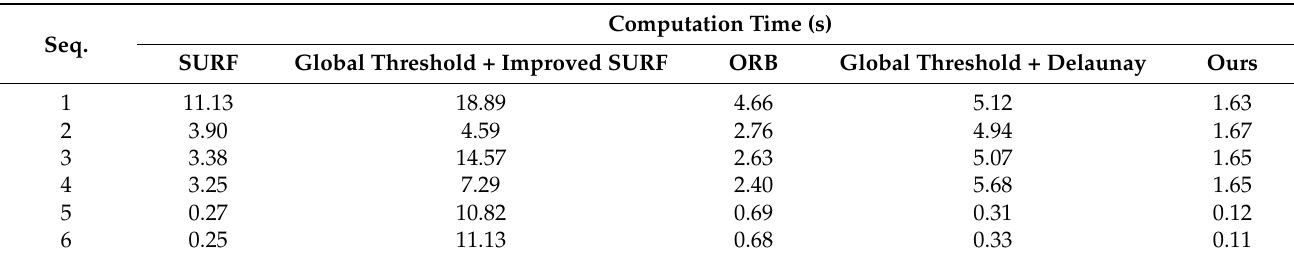
Table 5. Computational cost comparison for corresponding point-matching among the proposed method and baselines.